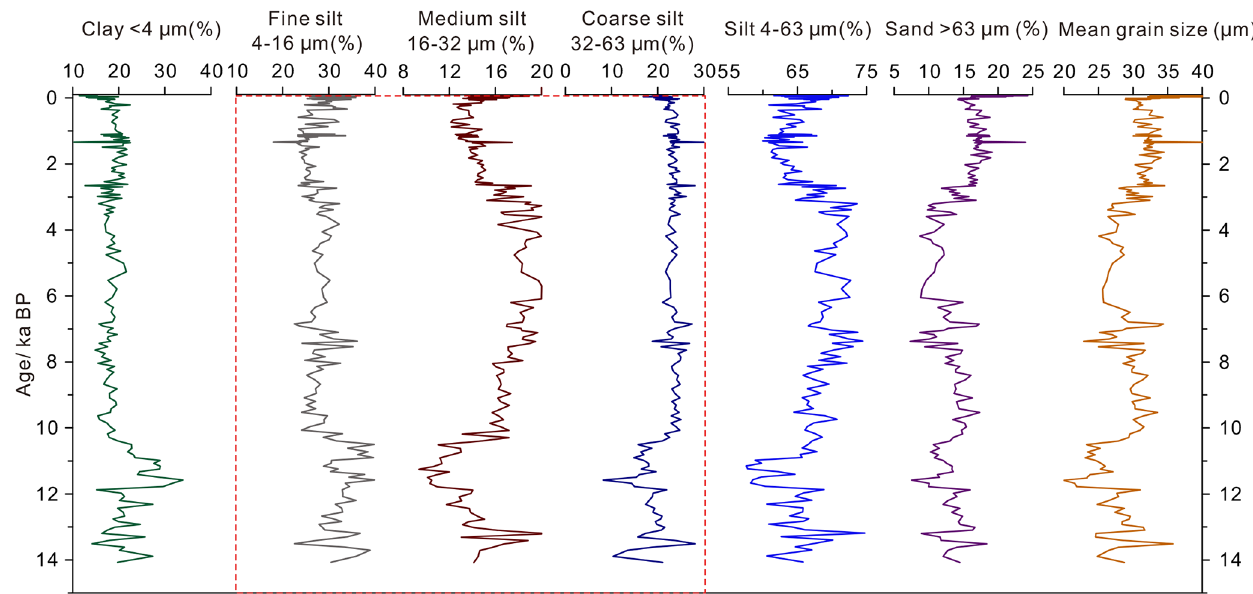
Figure A2. The percentage of different grain size components and mean grain size derived from Gahai Lake since 14.2kaBP.